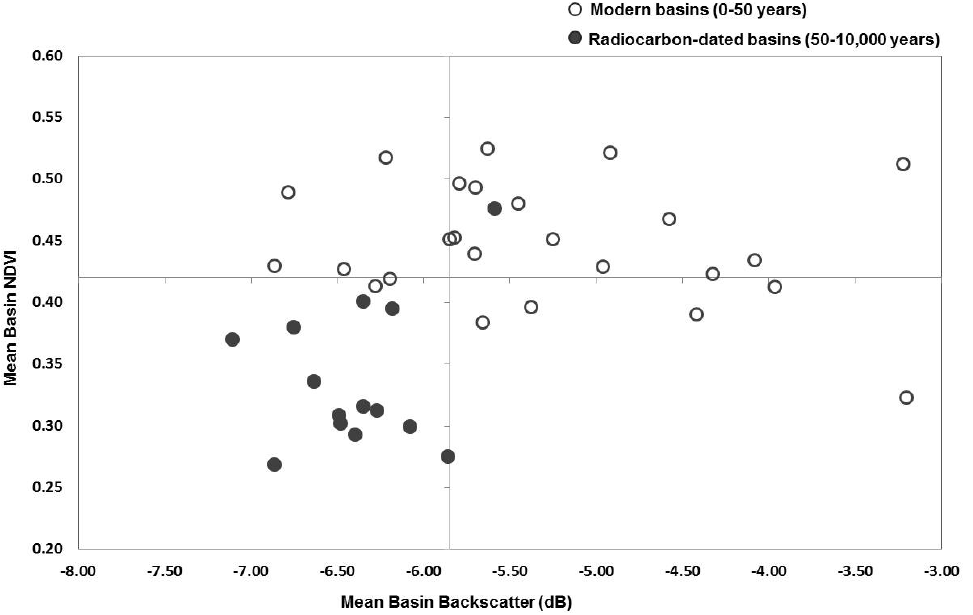
Figure 6. Distribution of backscatter and NDVI values of DTLBs showing the differences in backscatter and spectral properties of modern and radiocarbon-dated basins. The axes intersect at the median of each